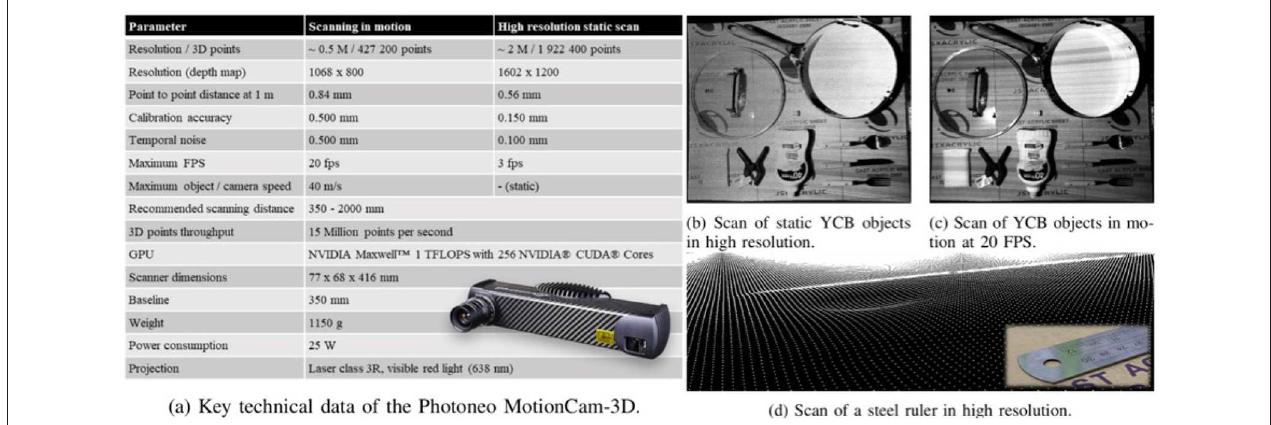
FIGURE 3 | The MotionCam-3D camera from Photoneo, including (a) the technical data sheet; and the captured point cloud of YCB objects (b) in high resolution static scan with nearly 2 million points captured at up to 0.150 mm accuracy under 3 FPS; and (c) in motion with nearly 0.5 million points captured at up to 0.500 mm accuracy at the maximum 20 FPS; (d) the captured point cloud of a steel ruler with thickness of 1 mm .